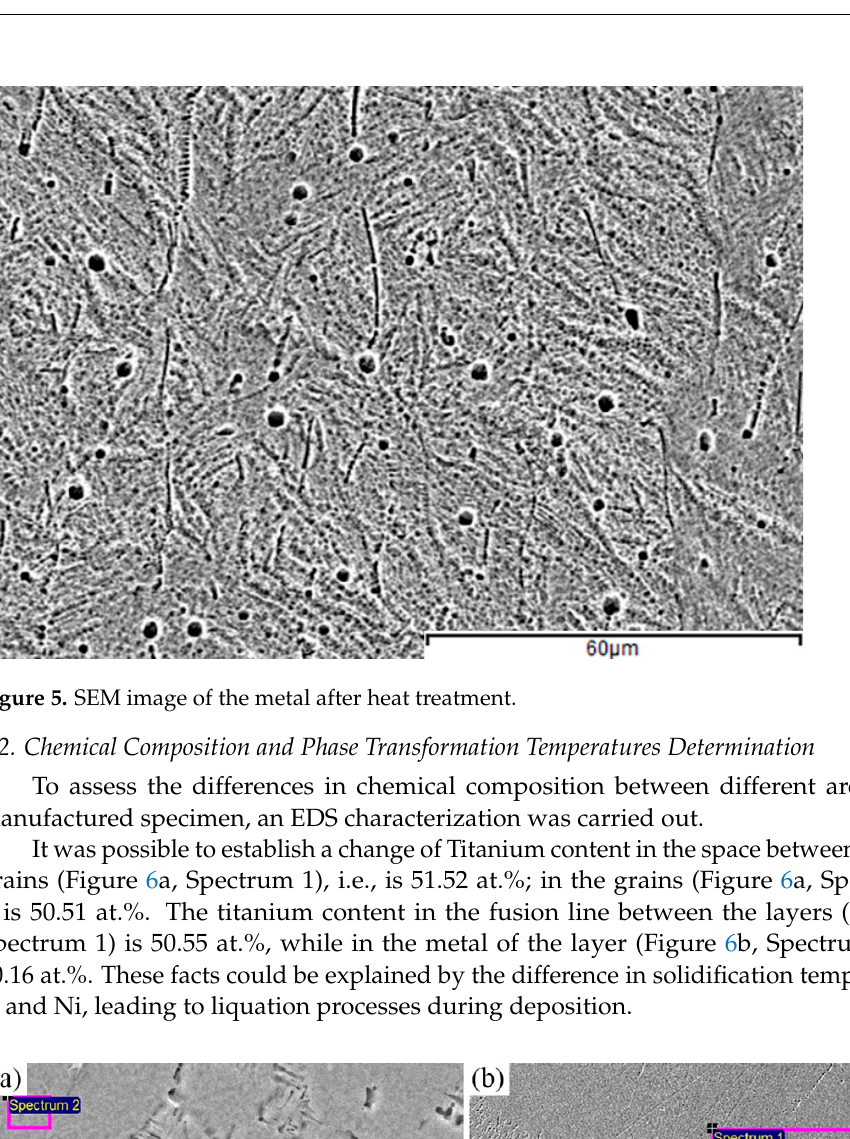
7 of 17 Figure 4. Microstructure of the heat-treated metal.